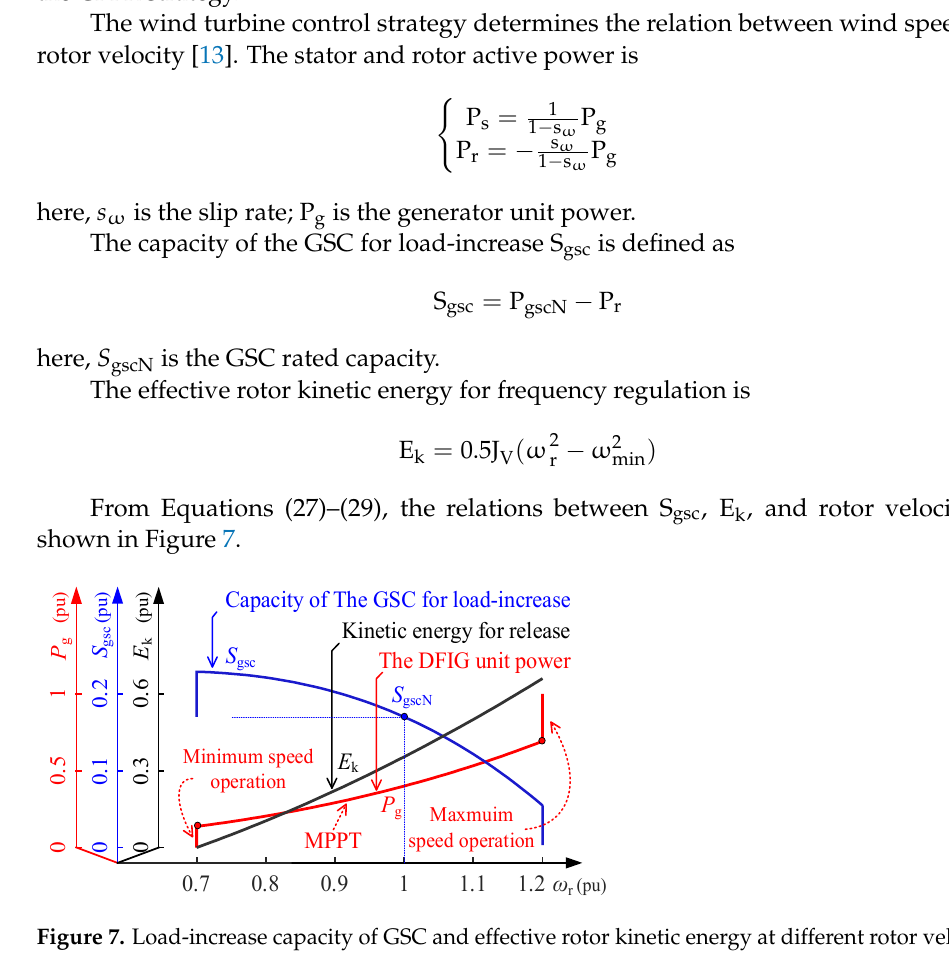
Figure 8. Coordinated primary frequency regulation strategy for a DFIG-VSG. The CPFR strategy assigns operating methods for the stator VSG, GSC, and ES based on wind speed conditions and stages in frequency perturbation. When grid frequency perturbations occur, the CPFR strategy assigns operating modes by different wind speeds. At high wind speeds, the stator VSG operates in both frequency inertial and PFR modes, GSC switches to constant power control, and ESS is used to maintain the DC bus voltage stability. At low wind speeds, the stator VSG oper- ates in frequency inertial mode, GSC in PFR mode, and ESS in DC voltage control mode. The CPFR strategy eliminates the overload of the GSC at high wind speeds and remedies the insufficient rotor kinetic energy at low wind speeds. When the grid frequency is restored, the stator VSG is in velocity recovery mode, GSC is in compensation control for stator load-shedding, and ESS remains in DC voltage control. The GSC compensation control reduces power loss during rotor velocity recovery. When the grid frequency is normal, the GSC switches to DC voltage control, and the ESS is in state of charge (SOC) control.